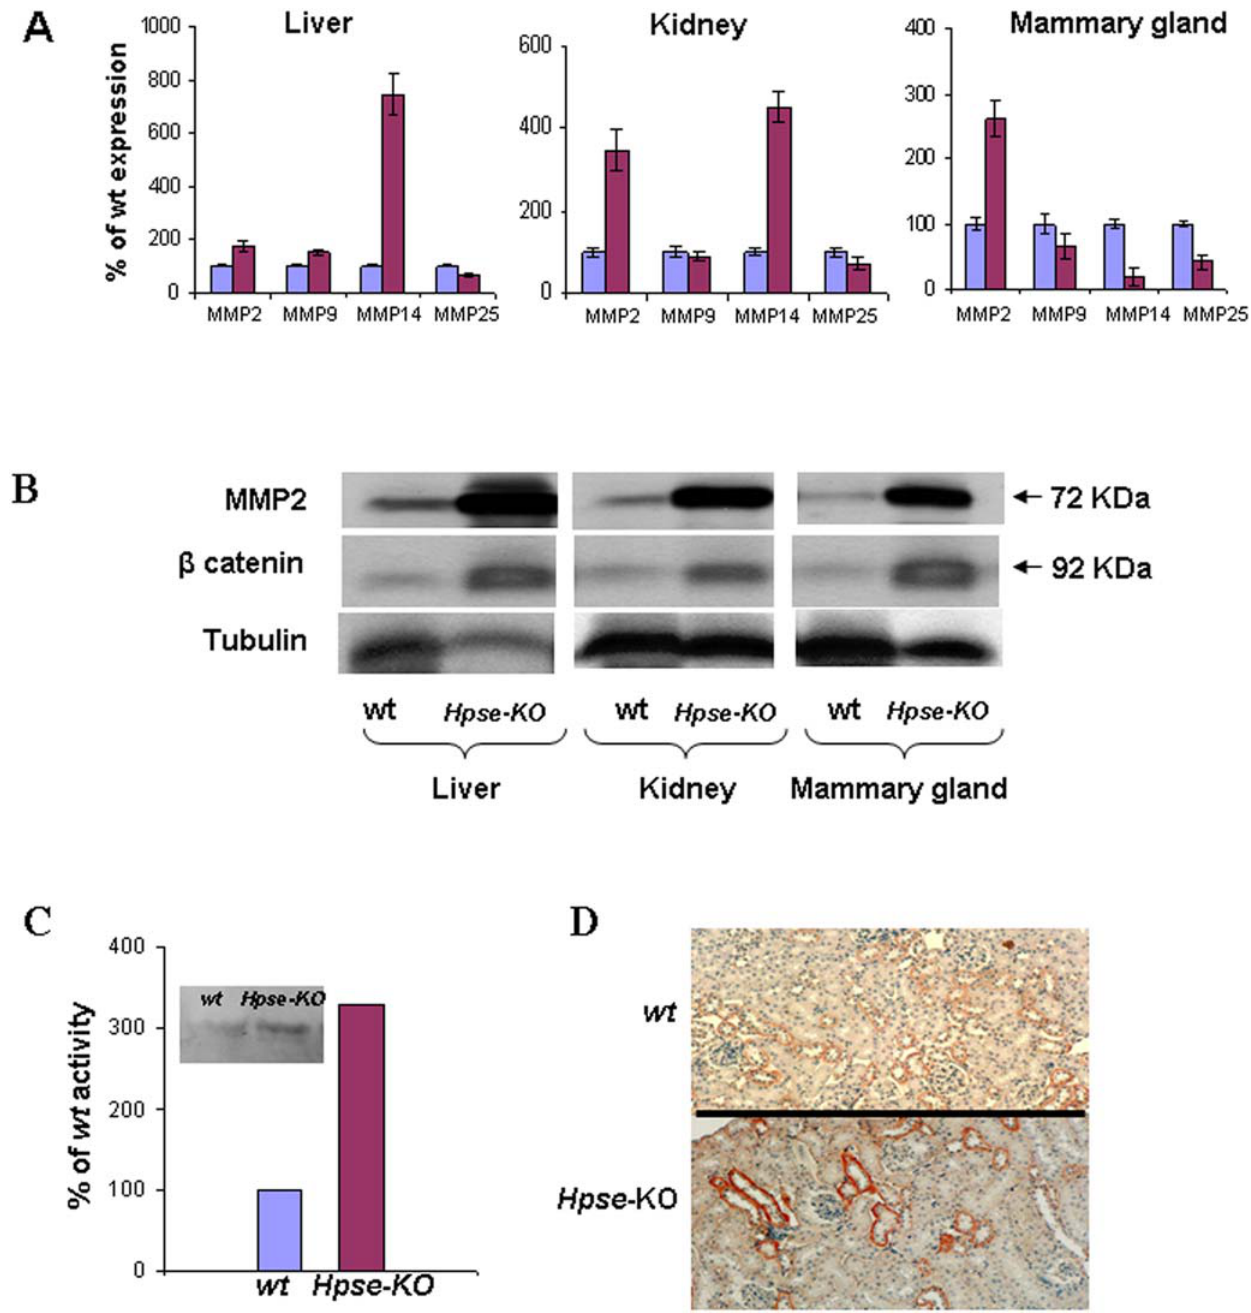
Figure 6. MMP expression in Hpse- KO mice. A. Real-time PCR. RNA was extracted from liver, kidney and mammary gland of wt and Hpse- KO mice and subjected to quantitative real time PCR analysis to evaluate the expression of MMP-2, MMP-9, MMP-14 and MMP-25. The expression level determined for each MMP in the wt tissue (blue) was regarded as 100% and the corresponding expression determined in the Hpse- KO tissue (Purple) are presented as percentage relative to it. Each reaction was repeated 6 times and the mean 6 SD is indicated. B. Western blot analysis. Liver, kidney and mammary gland tissue extracts, prepared as described in ‘‘Materials and Methods’’, were subjected to Western blot analysis using anti-mouse MMP-2 monoclonal antibodies (mA801B; upper panels), anti mouse b -catenin (mAb610154; middle panels), or anti mouse a -tubulin (B-5-1-2; lower panels). Higher protein levels of MMP-2 and b -catenin were detected in samples derived from Hpse- KO vs. wt tissues. C. MMP2 zymography. Serum samples derived from Hpse- KO and wt mice were evaluated for MMP-2 activity. MMP-2 activity was approximately 3 fold higher in plasma samples derived from Hpse- KO vs. wt mice. D. b -catenin immunostaining. Parafin embedded kidney tissue sections were subjected to immunostaining with antibody directed against b -catenin. Increased staining was observed in kidney derived from Hpse- KO vs. wt mice.